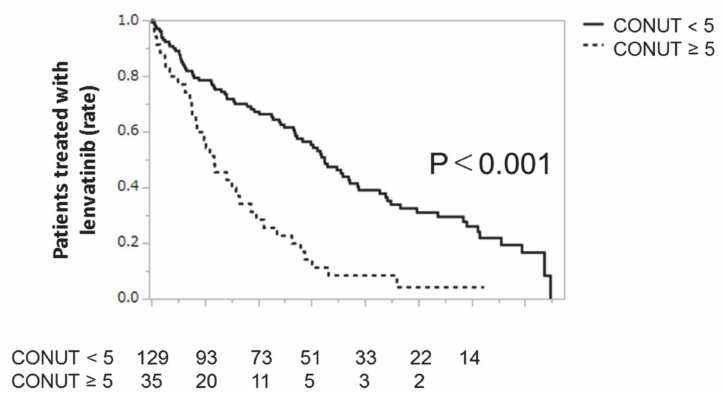
Figure A2. Duration of treatment with lenvatinib according to CONUT score. Kaplan–Meier curves for the duration of treatment with Lenvatinib, according to CONUT score. The solid line represents the low CONUT group (CONUT score < 5). The dotted line represents the high CONUT group (CONUT score ≥ 5). Abbreviations: CONUT, Controlling Nutritional Status.